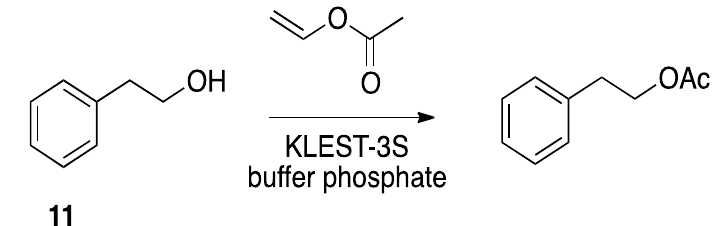
15 of 20 Figure 6. Hydrolysis of different esters to corresponding acid. Reaction time, 24 h; temperature, 65